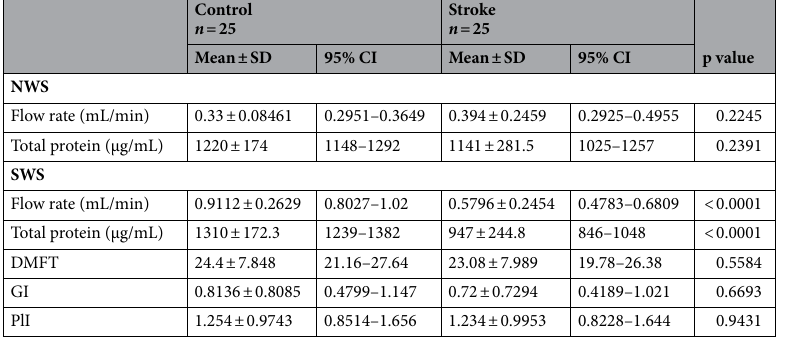
Table 3. Salivary gland function and dental characteristics of the stroke and healthy controls. NWS non- stimulated whole saliva; SWS stimulated whole saliva; DMFT index a sum of decayed teeth (DT), teeth missing due to carious process (MT), and teeth filled because of caries (FT); GI Gingival Index; PlI Plaque